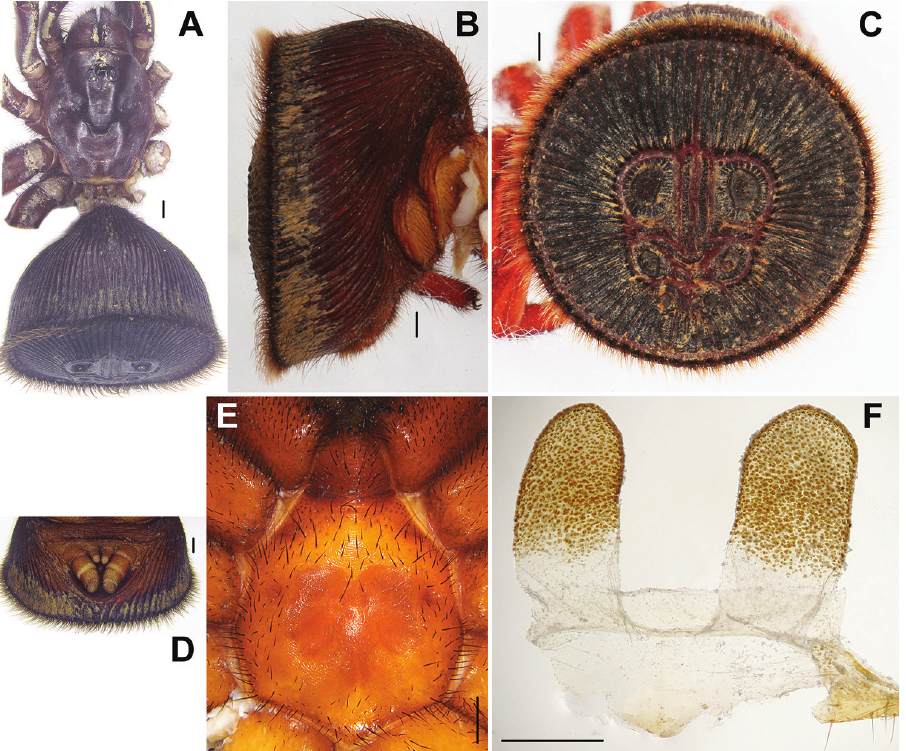
Figure 3. Cyclocosmia liui Xu, Xu & Li sp. n. A habitus of female (C-XUC-2015) B abdomen, lateral view C abdomen, caudal view D posterior portion of opisthosoma, ventral view, showing spinnerets E sternum, ventral view F female genitalia, ventral view. Scale bars A–E 1 mm, F 0.5